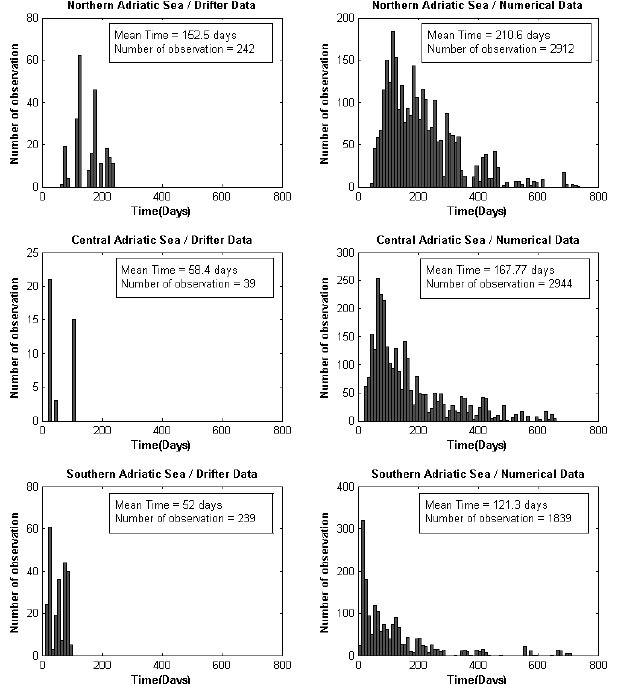
Fig. 2. Example of transit time pdfs computed from numerical (right) and real (left) particles starting in the selected areas shown in Fig. 1b in the northern (top), central (middle) and southern (bottom) Adriatic and leaving the Adriatic Sea through the western Otranto Channel.